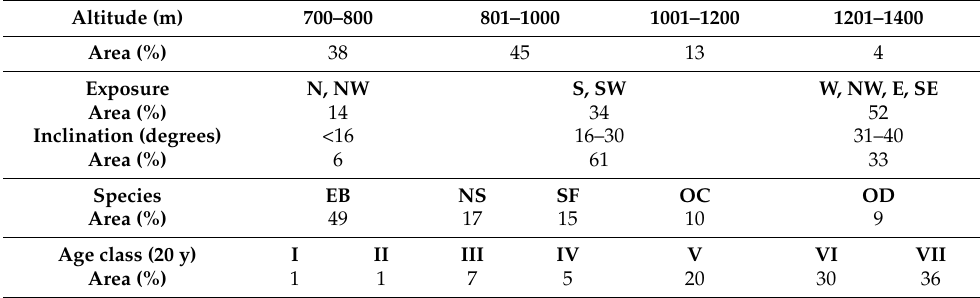
Table 1. Characteristics of the management unit.